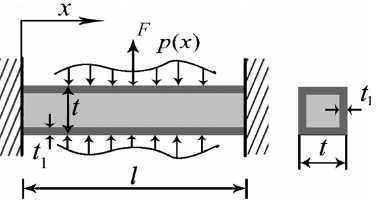
Figure 2 Clamped-clamped square nanobeam subjected to a lateral force F . The residual surface stress acts as a distributed load p ( x )